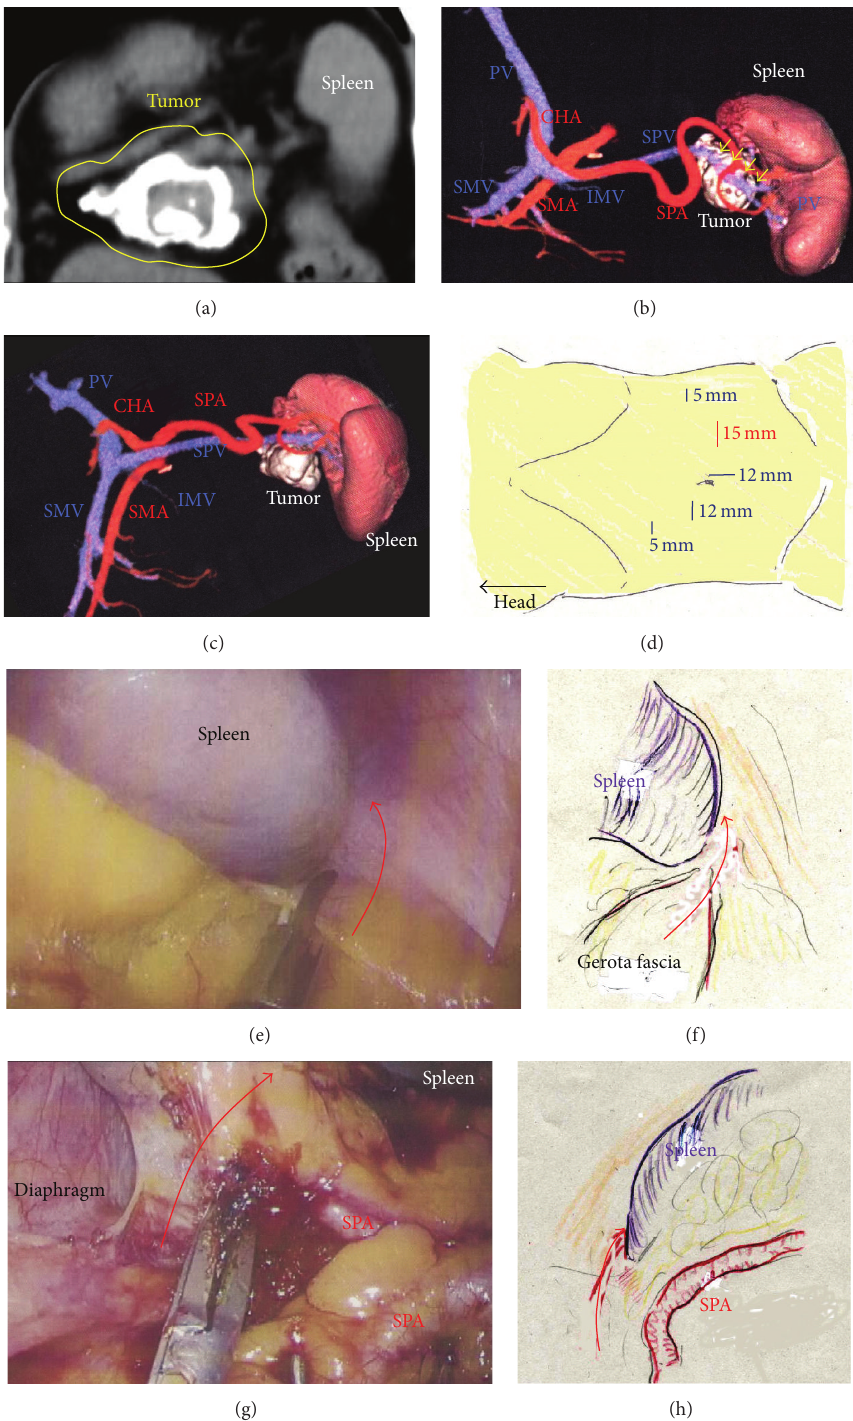
Figure 1: (a) The tumor surface was severely calcified (yellow circle). (b) Three-dimensional images revealed that the tumor involved the SPV (yellow arrows). (c) The SPA was not involved in the tumor. (d) A total of five ports were placed. (e) and (f) The inferior ligament of the spleen was cut (red arrow). (g) and (h) The superior ligament of the spleen was cut (red arrow). SPA, splenic artery; SPV, splenic